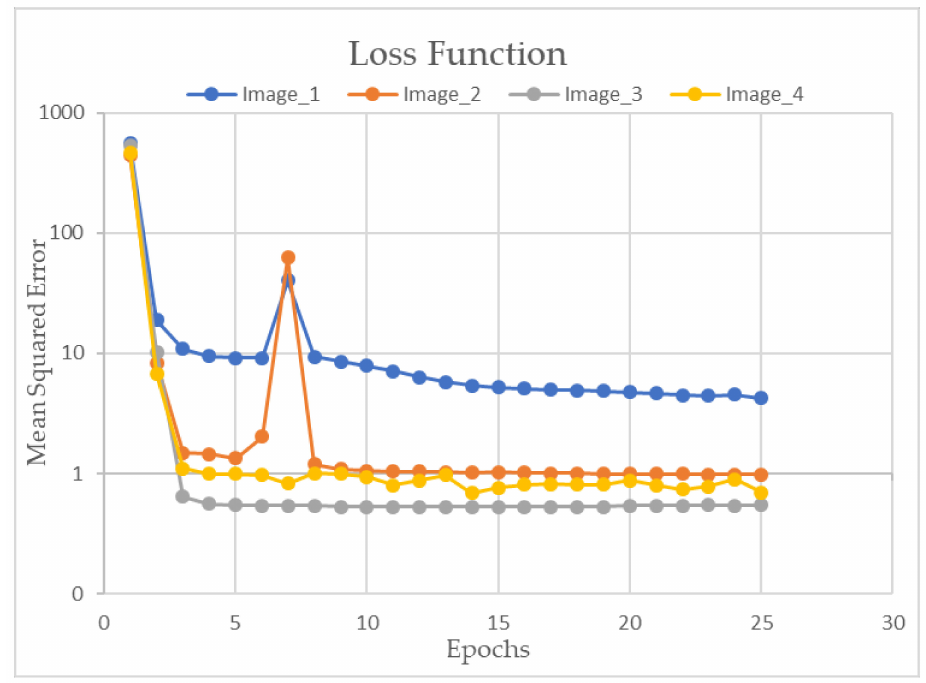
Figure 20. Semi-log plot of the loss function for the neural networks trained over the four di ff erent images in the